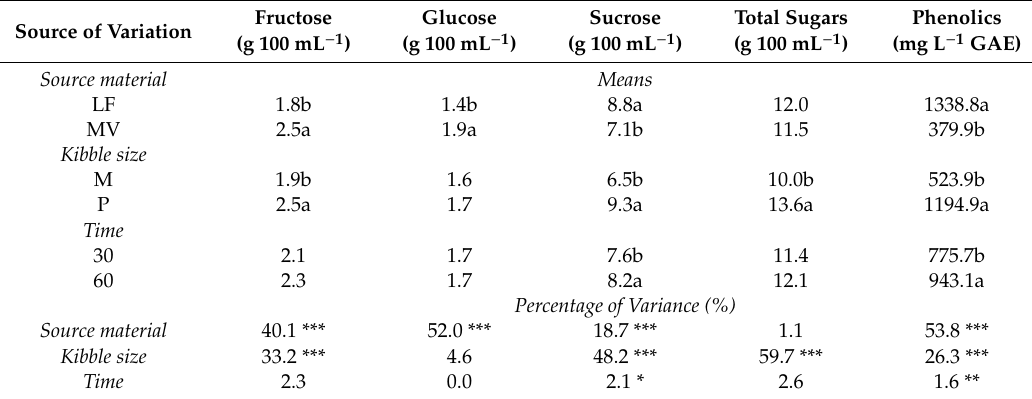
Figure 2. Interaction plots for total phenolics and sugars obtained by ultrasound-assisted extraction (UAE; ( A , B )) of di ff erent source materials (LF: Lefkaritiki; MV: Mavroteratsia) and kibble sizes (medium and powder). UAE extraction varied in extraction time (30 and 60 min). Data points represent means of three replicates with standard error bars. Table 2. Percentage of variance explained by main e ff ects and mean comparisons for fructose (FRU), glucose (GLU), sucrose (SUC), total sugars, and phenolics obtained by ultrasound-assisted extraction (UAE) using two source materials (LF: Lefkaritiki; MV: Mavroteratsia) and two kibble sizes (M: medium-size kibbles; P: powder-size kibbles) under two extraction times (30 and 60 min). Interaction plots of main e ff ects on phenolics and sugars are presented separately in Figure 2A,B,